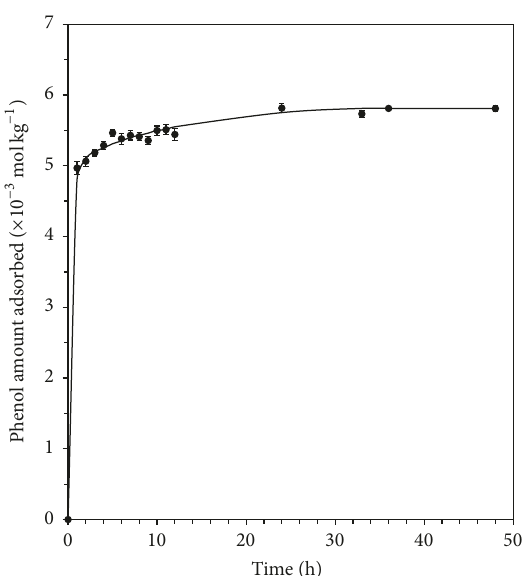
Figure5:Evaluationofcontacttimeintheextractionofphenolwith CA-MC-Cy. Experimental conditions: 50 mL of phenol at 25 mgL −1